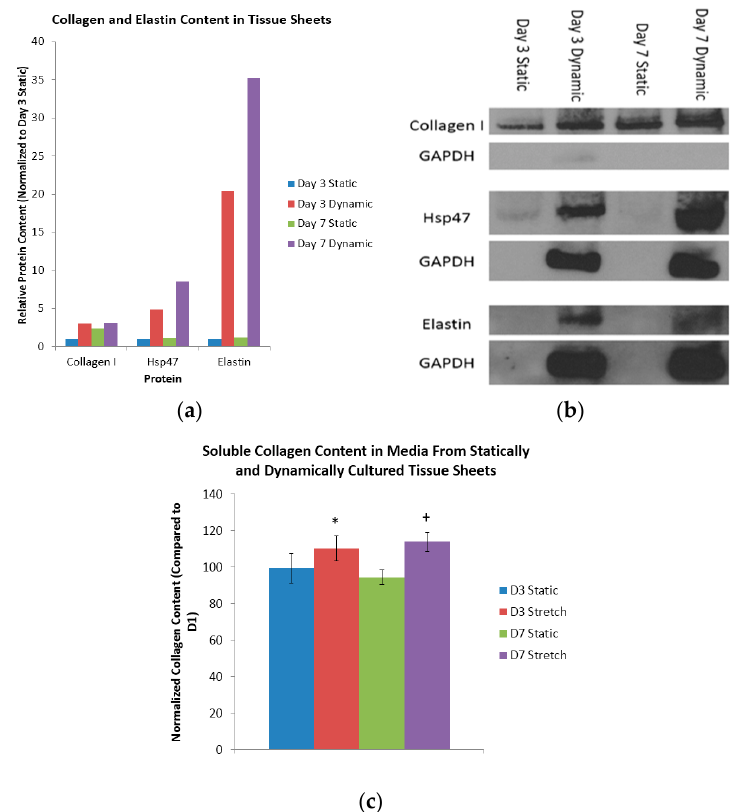
Figure 3. Insoluble and soluble protein content in tissue sheets. ( a ) Quantification of collagen I, Hsp47, and elastin content in tissue sheets with and without cyclic longitudinal stretching mediated by magnetic forces using Western blot; the results are normalized to day three static tissue sheets; ( b ) representative protein and glyceraldehyde 3-phosphate dehydrogenase (GAPDH) bands from the Western blots; and ( c ) the normalized soluble collagen content in the media of statically- and dynamically-conditioned tissue sheets after three and seven days: n = 3 (“*” and “+” indicate a statistical significance for the D3 and D7 stretch samples when compared to the D3 static control sample).